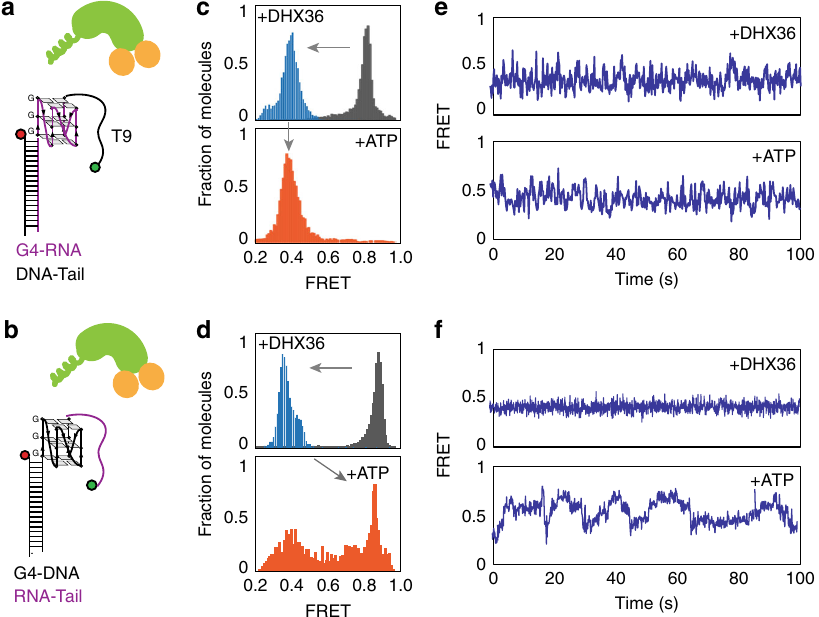
Fig. 4 ATP dependent G4-RNA refolding arises from RNA tail, not G4. a , b Chimeric constructs of G4-RNA with ssDNA tail (A) and G4-DNA with ssRNA tail to which DHX36 was added. c , d FRET histograms for substrate only (gray), after DHX36 addition and buffer wash (blue) and after 1 mM ATP addition (orange). e , f Representative smFRET traces obtained in each condition as